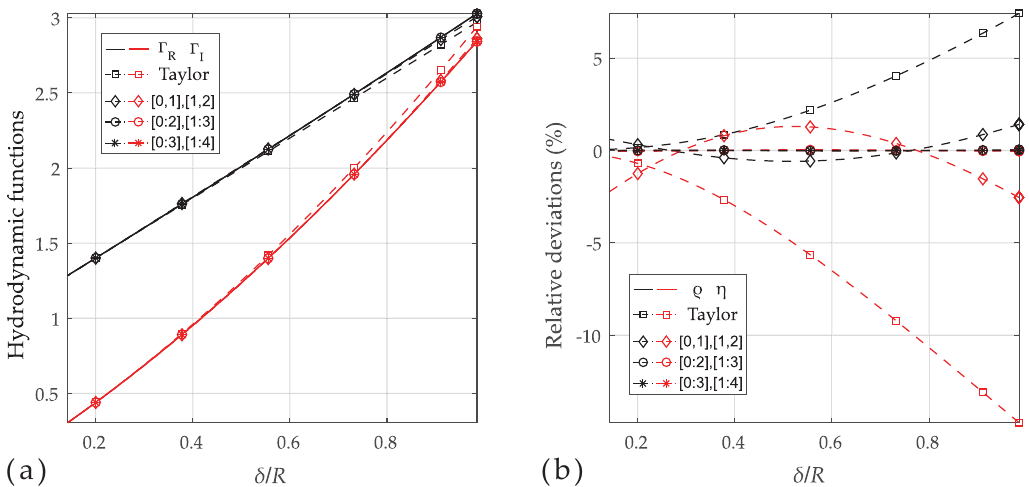
Figure 4. ( a ) Real (black) and imaginary part (red) of the hydrodynamic function (solid line) in Equation (2), power series model in Equation (7) ( (cid:3) ) and three different orders of approximations (e.g., [0:2],[1:2] means that coefficients a 0 . . . a 2 and b 1 . . . b 3 in Equation (16) are non-zero). ( b ) The deviations between reference and estimated viscosities and densities. Deviations are reduced with increasing order and remain below 0.015% for [0:3],[1:4]